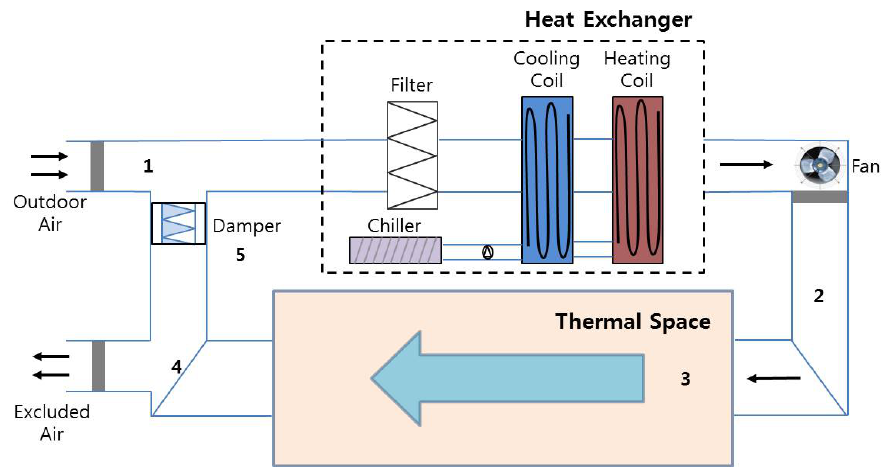
Figure 1. Model of the representative conventional HVAC